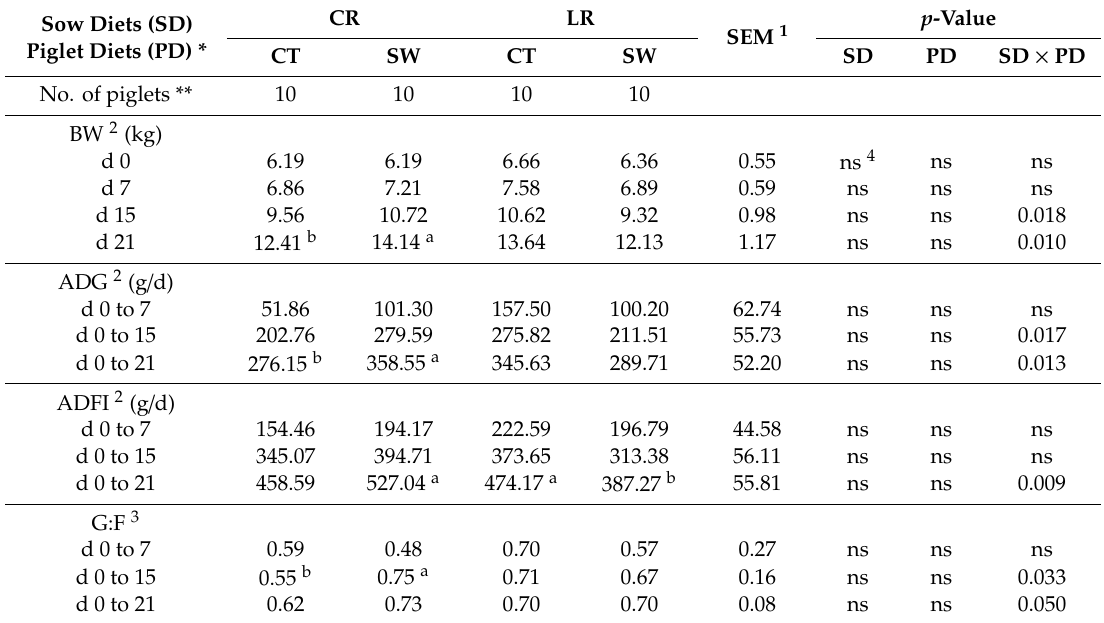
Table 4. Growth performance of post-weaning piglets fed seaweed